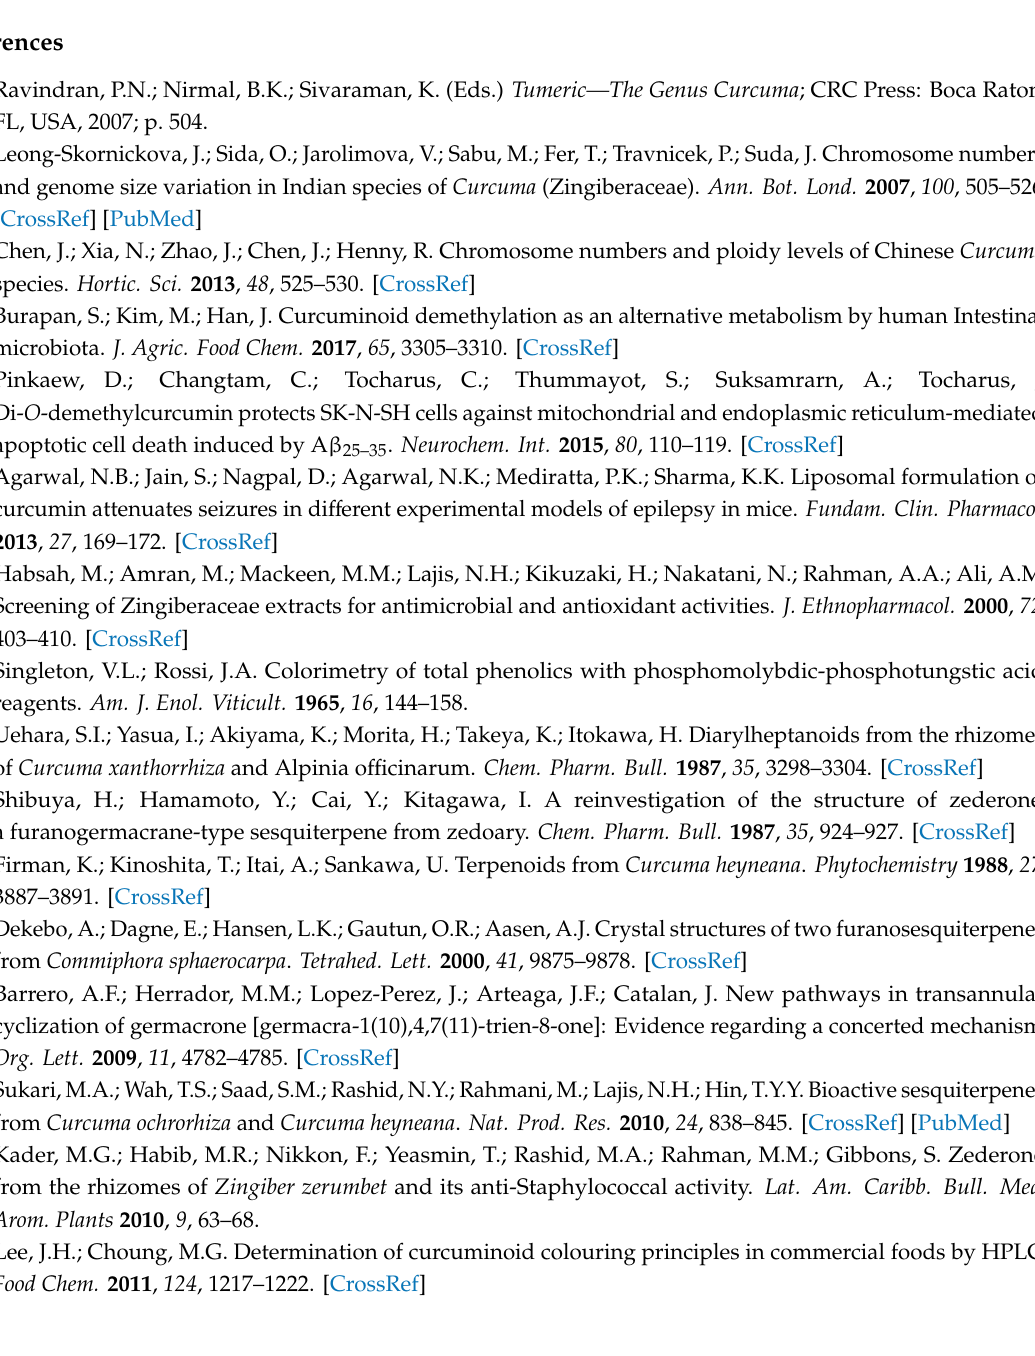
Table S1: List of 23 Curcuma species, Figure S1: Spectral data for the isolated compounds, Table S2: Taxonomy of 23 Curcuma